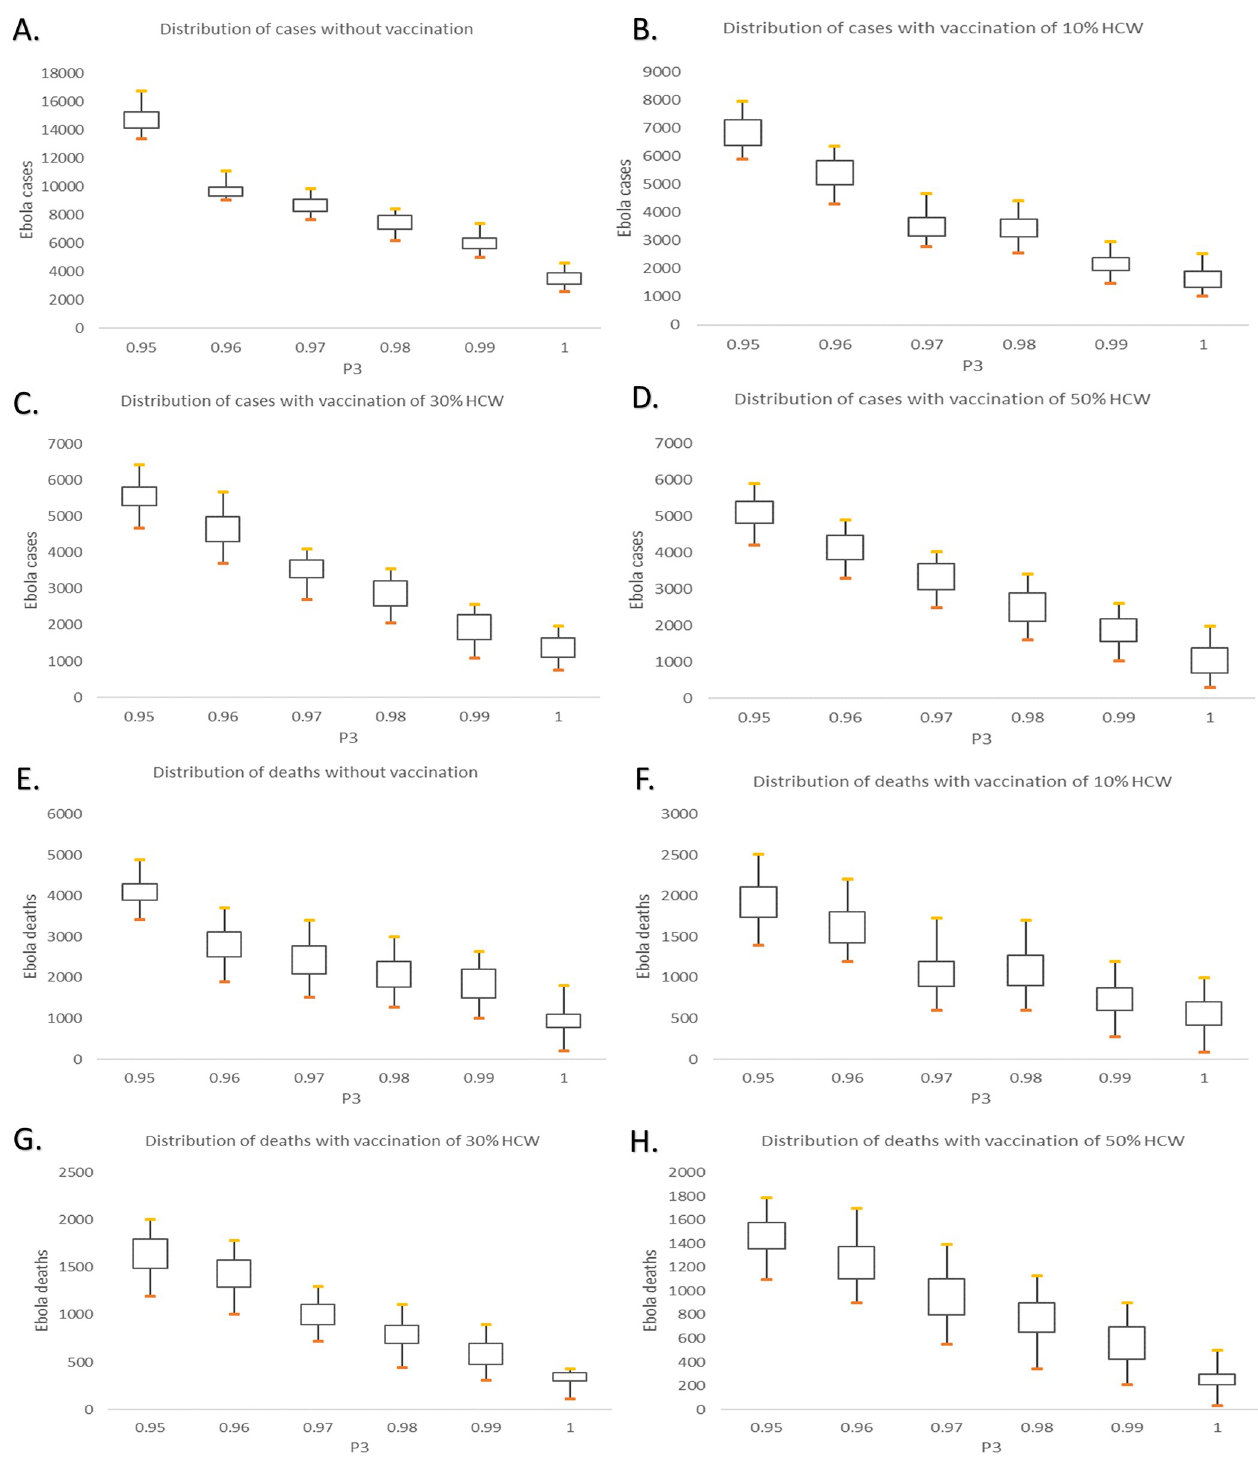
Fig 10. The median, interquartile range and 1.5 times the interquartile range of the simulation output under different combination of interventions. A-D: Cumulative cases under different combination of intervention strategies. E-H: Cumulative deaths under different combination of interventions.